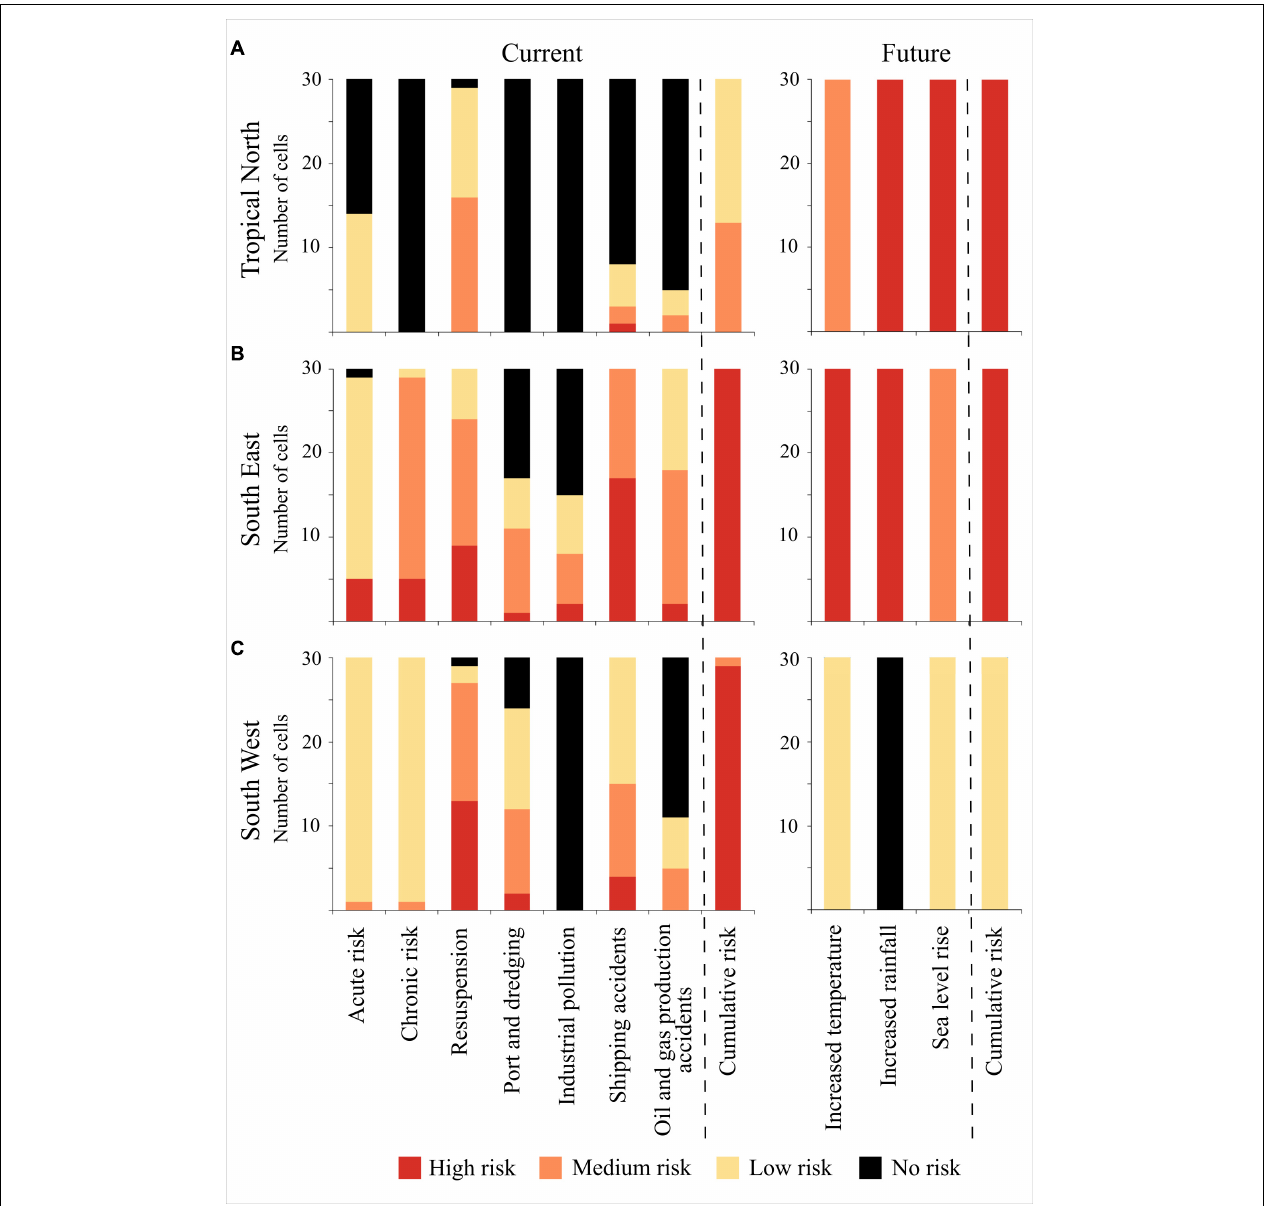
FIGURE 4 | Case study of 30 seagrass cells from each bioregion. (A) Tropical North (Gulf of Carpentaria), (B) South East (Sydney-Newcastle), and (C) South West (Albany) showing the breakdown of individual threats contributing to the current cumulative risk (left) and future cumulative risk (right). A similar cumulative risk (e.g., high) can be derived from different combinations of individual